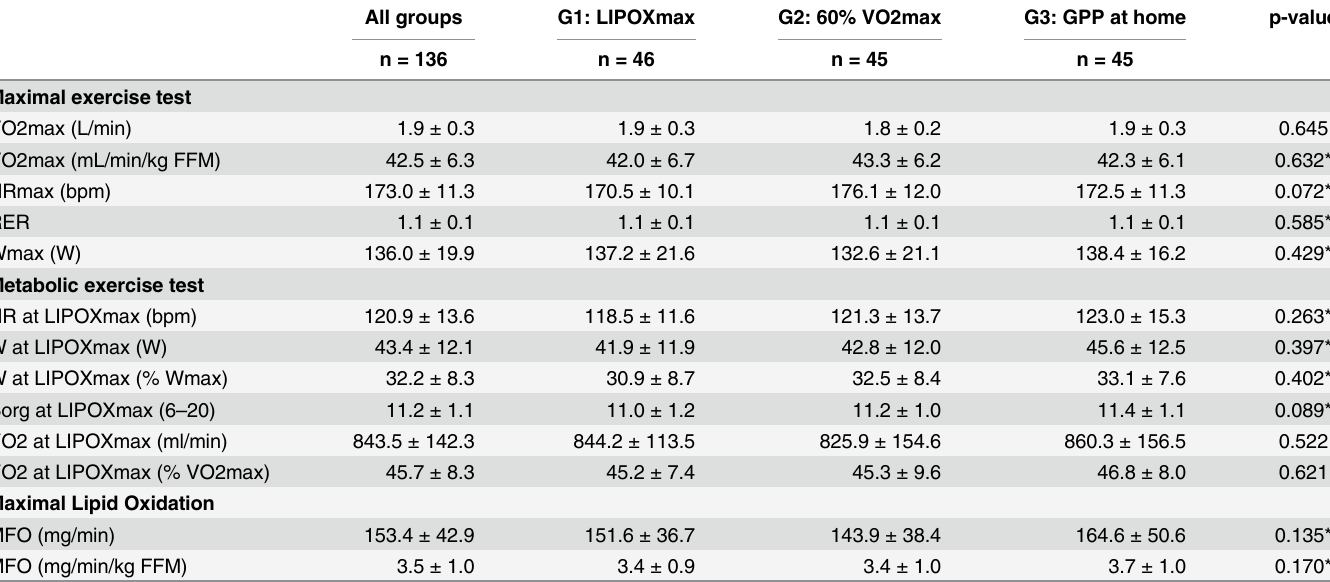
Table 2. Baseline exercise tests at inclusion for LIPOXmax-Réunion randomized controlled trial